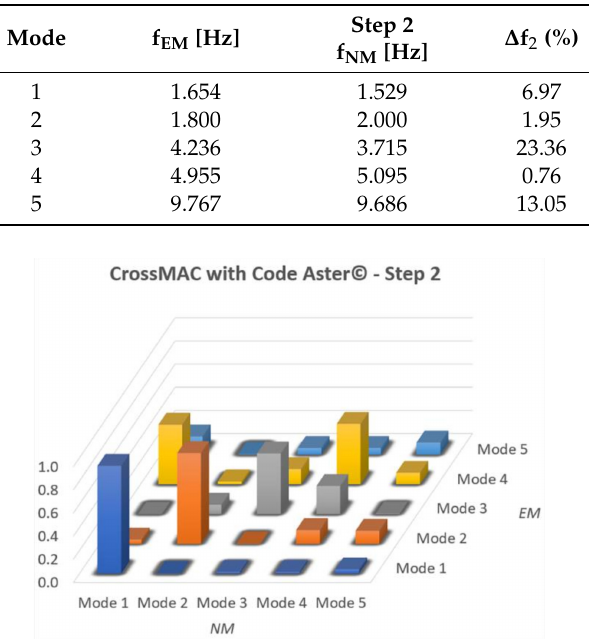
Table 6. Comparison between EM and NM frequencies at step 2 with Code Aster © .